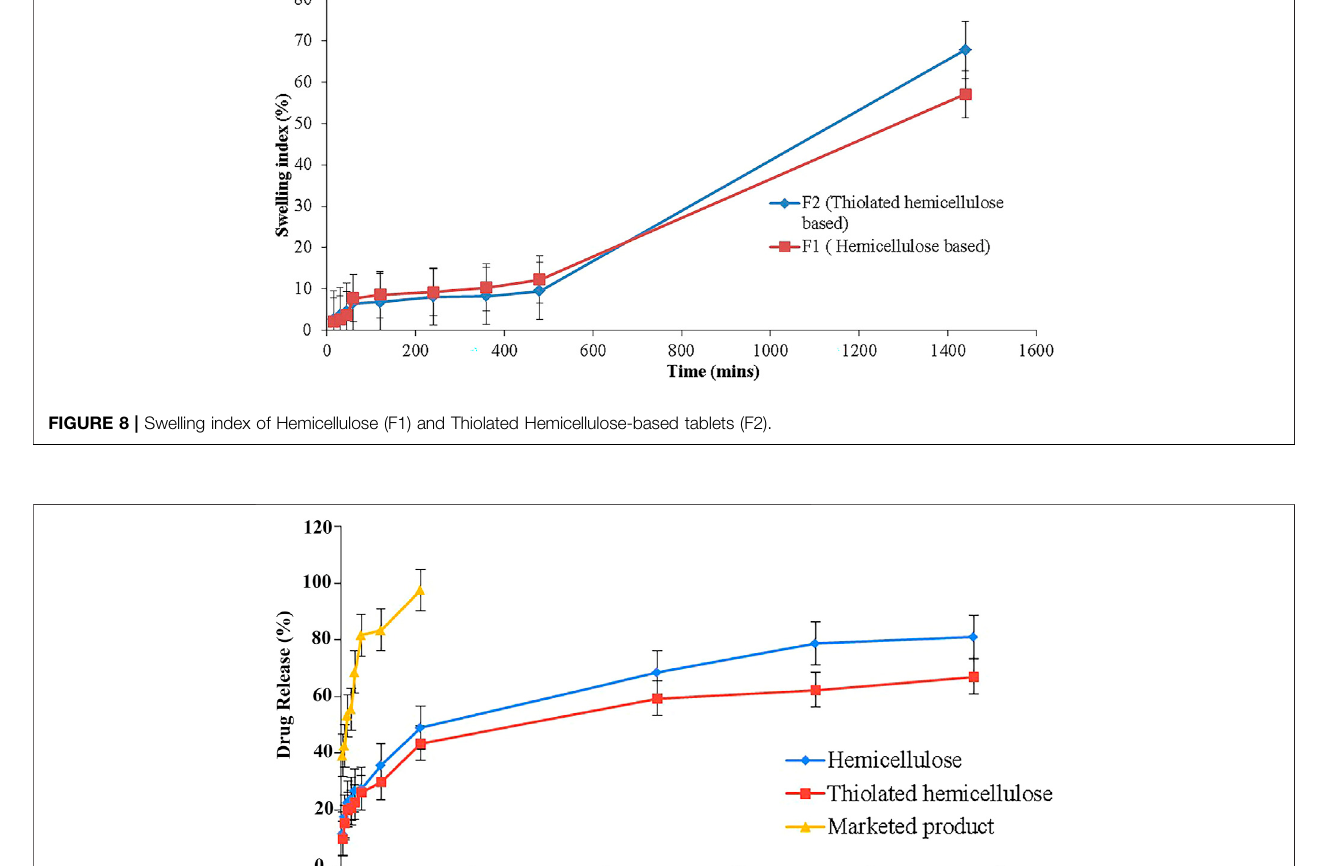
Frontiers in Pharmacology |